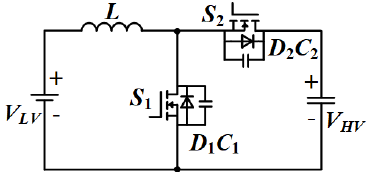
Figure 1. Topology of bidirectional